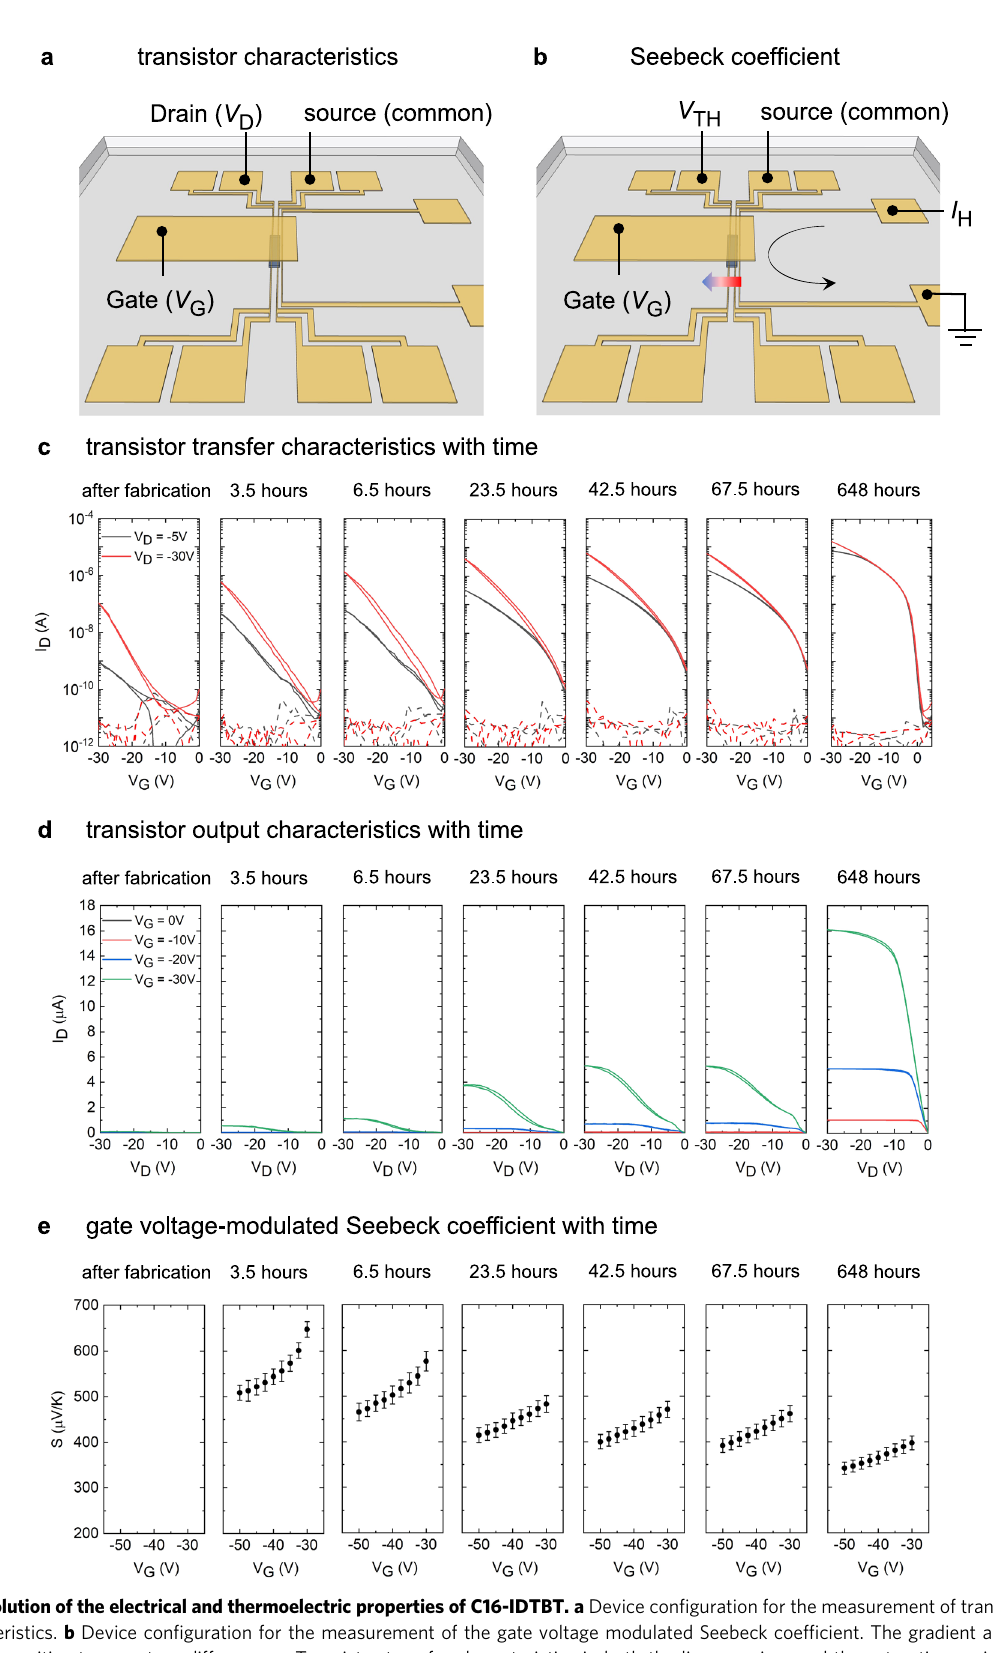
Fig. 2 Time evolution of the electrical and thermoelectric properties of C16-IDTBT. a Device con fi guration for the measurement of transistor transfer and output characteristics. b Device con fi guration for the measurement of the gate voltage modulated Seebeck coef fi cient. The gradient arrow indicates the direction of the positive temperature difference. c Transistor transfer characteristics in both the linear regime and the saturation regime over time. The dotted lines are the gate leakage currents in the dielectric. d Transistor output characteristics over time. e Gate voltage modulated Seebeck coef fi cient measured over time in ambient air, in which the error bars arise from the linear fi t of the thermal voltage to the applied temperature differential (See Supplementary Information Section